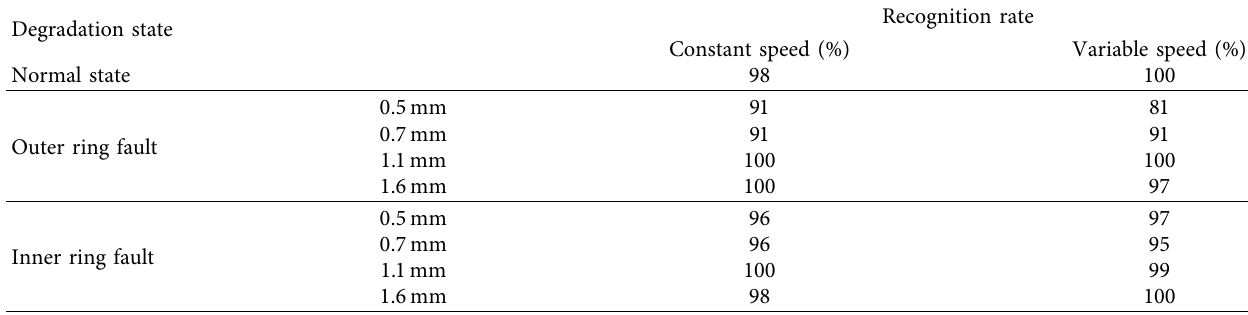
Table 3: Degradation identification results.